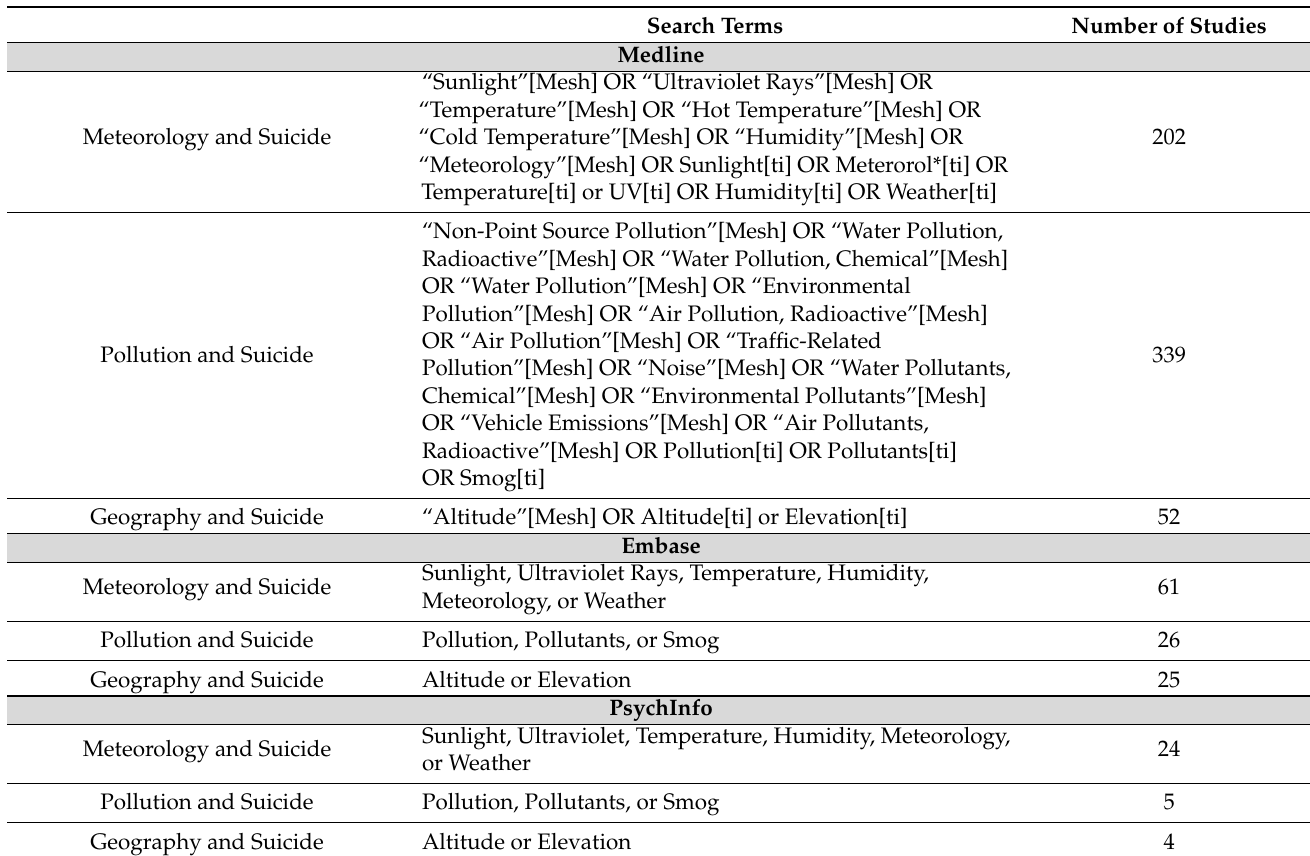
Table 1. Search terms used for each